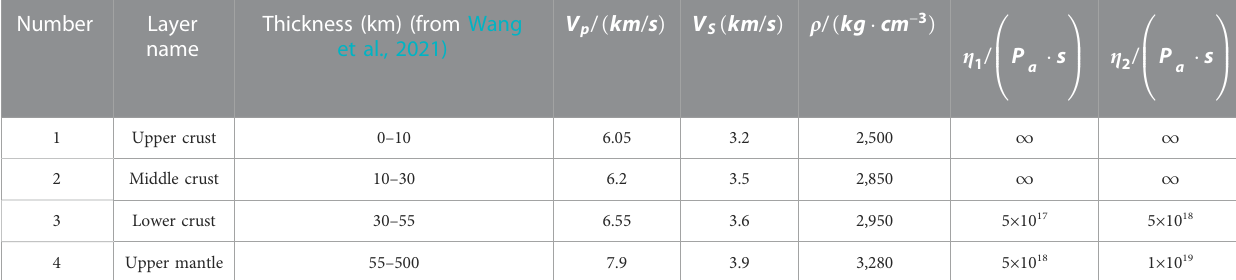
TABLE 3 Parameters of the crust and upper